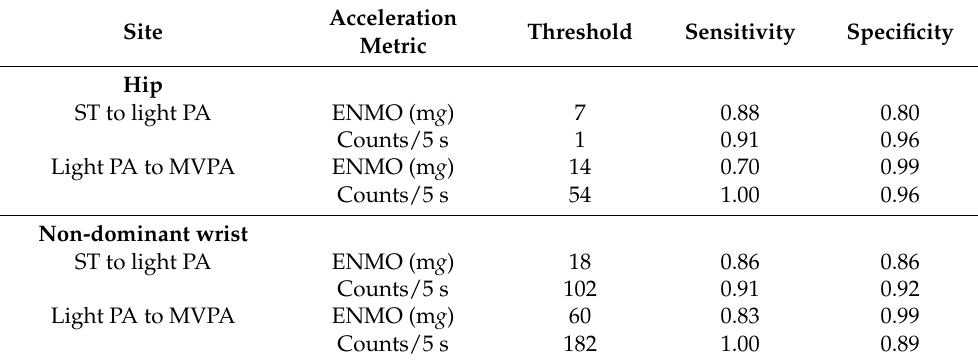
Table 5. Cross-validation of the previously derived thresholds to classify ST, light, and MVPA intensities in the cross-validation sample (MOBEMENT). Acceleration Threshold Sensitivity Specificity Site Metric Hip ST to light PA ENMO (m g ) 7 0.88 0.80 Counts/5 s 1 0.91 0.96 Light PA to MVPA ENMO (m g )